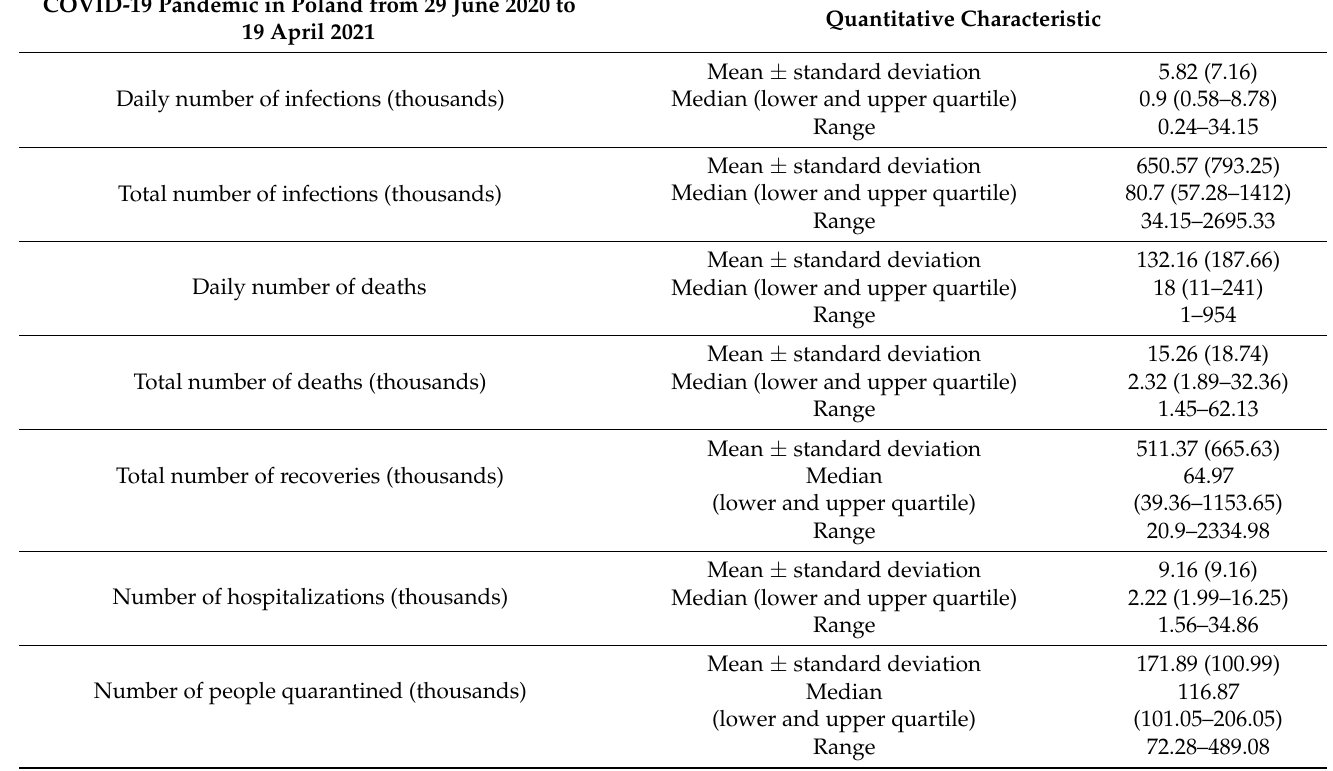
Table 2. Statistical characteristics of the intensity of the COVID-19 pandemic in Poland in the analyzed period.